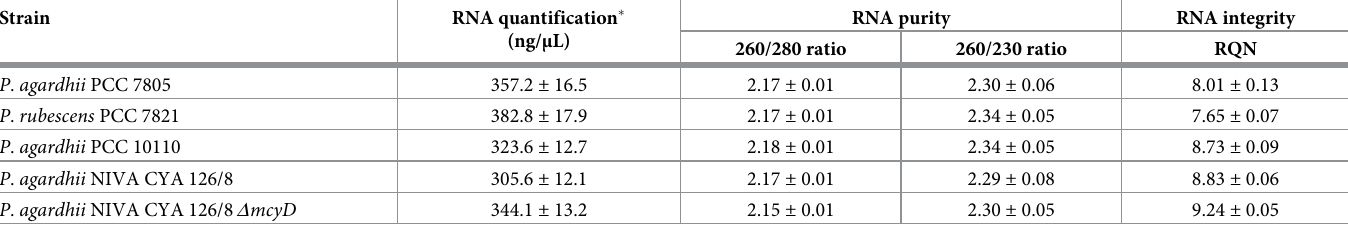
Table 4. RNA quantification, purity and integrity for the optimized homogenization method based on HI ultra-sonication presented in Fig 3 tested on different Planktothrix stains (n = 63 for each strain). RQN: RNA Quality